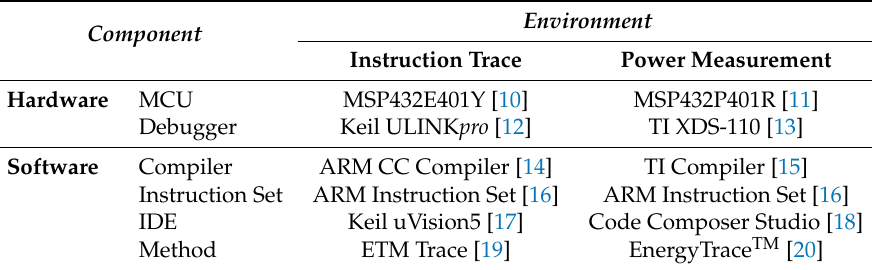
Table 1. Environment